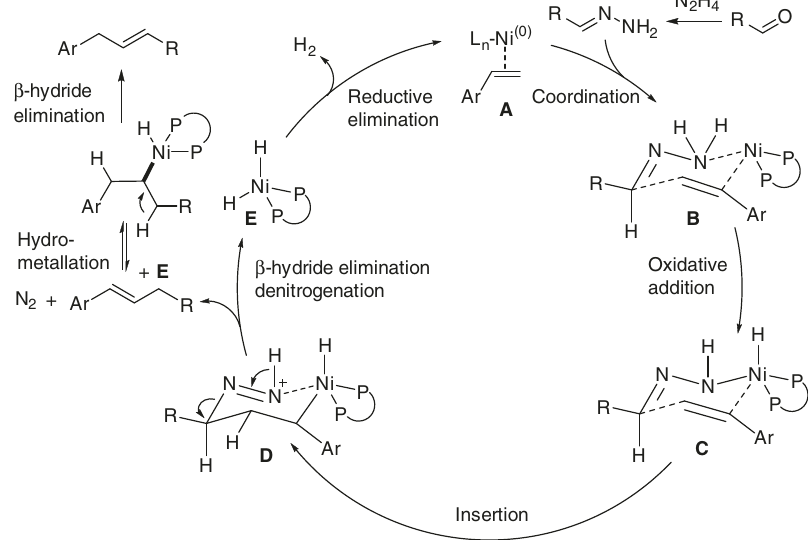
Fig. 5 Reaction mechanism. Proposed pathway for the oxidant-free Heck-type reaction NATURE COMMUNICATIONS| (2019) 10:715